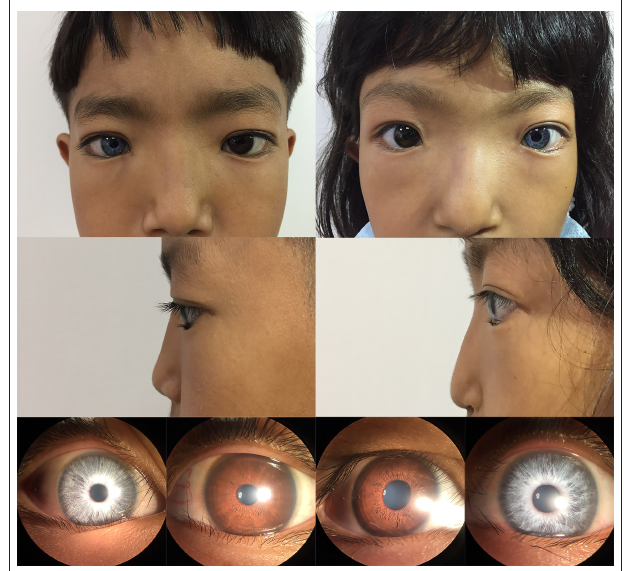
FIGURE 2 | Photographic features of appearance and iris pigment in III-1 and III-2. Synophrys, and broad, and high nasal root without forehead white hair can be observed in III-1 (proband) and III-2. The iris color in the right eye of III-1 is off-white and the left eye is brown. The iris color in the right eye of III-2 is brown and the left eye is